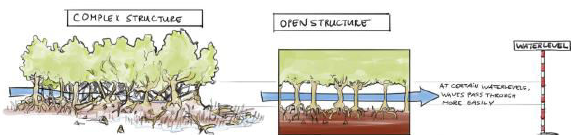
Figure 1 . Mangroves reduce the height and energy of wind as well as waves as they pass through their roots and branches which are tangled above-ground (Spalding et. al., 2014).